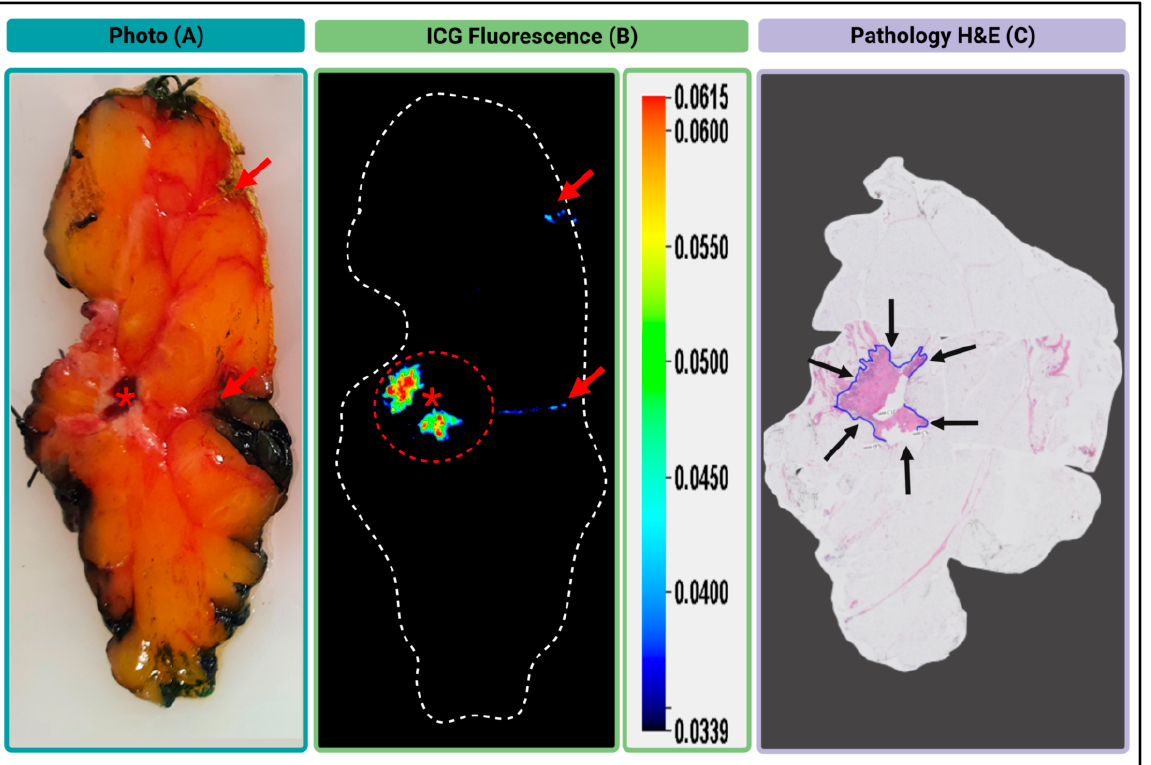
Figure 6. Ex vivo fluorescent imaging of the human BCa lumpectomy tissue sample. ( A )—Color photo of the surface of the fresh cut of the human lumpectomy sample. Red asterisk indicates a blood clot. ( B )—Image of 6QC-induced cathepsin-dependent ICG-fluorescence of the sample surface after topical application of AKRO-QC-ICG imaging gel (800 nm). The red dotted circle shows a high fluorescent ICG signal that corresponds to the tumor region of the sample. ( C )—H&E histology of the sample at low magnification. Blue line and black arrows represent the tumor area. Notes: red arrows indicate spots of the yellow pathological ink in ( A ) and non-specific fluorescence in ( B ) on the surface and edge of the sample. Imaging—Pearl Trilogy Imaging System.